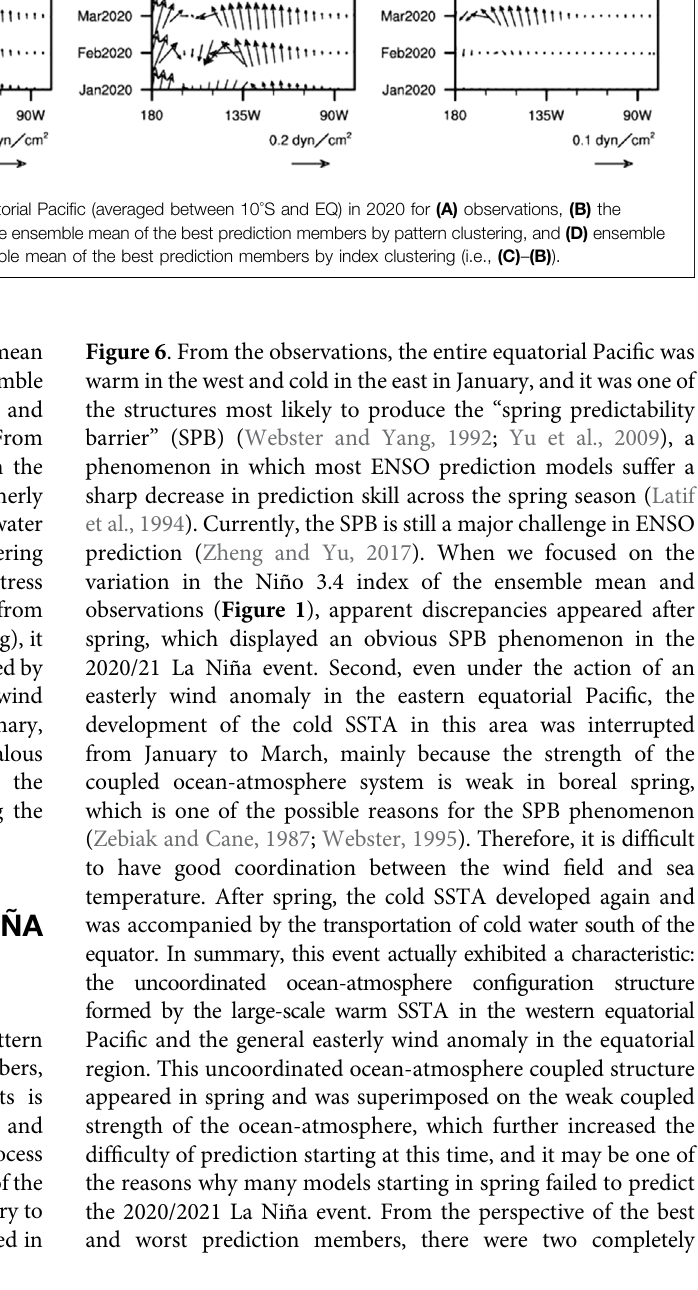
Frontiers in Earth Science |